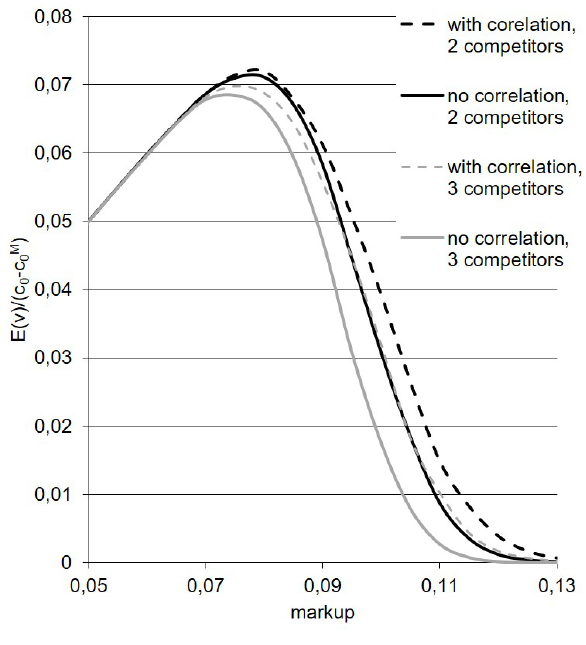
Figure 4: Simulation results: expected profit to cost ratio E ( V ) against markup for different number of competitors and at different correlation levels (description in the